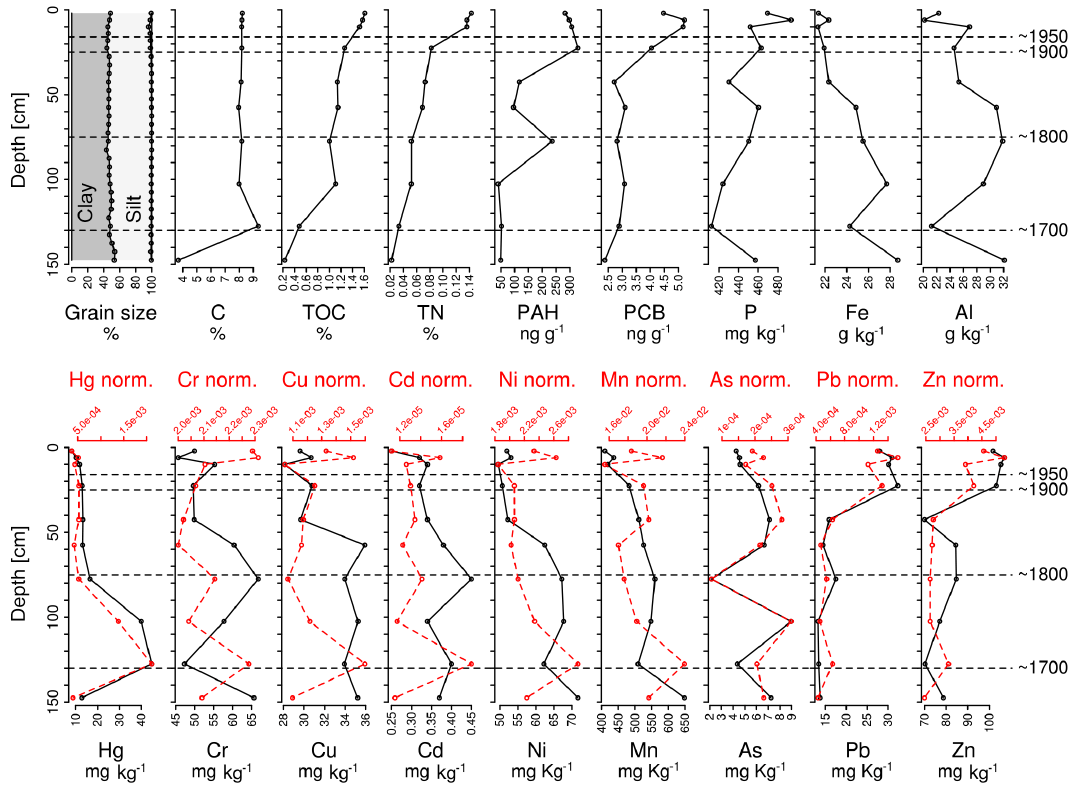
Figure 3. Vertical changes in grain size, major, minor and trace elements, nutrients and persistent organic